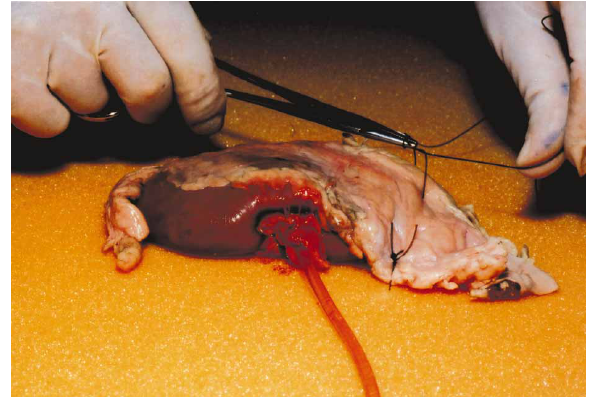
Figure 1 - The kidney is fixed with sutures to the back foam sheet. Note that the ureter is catheterized.